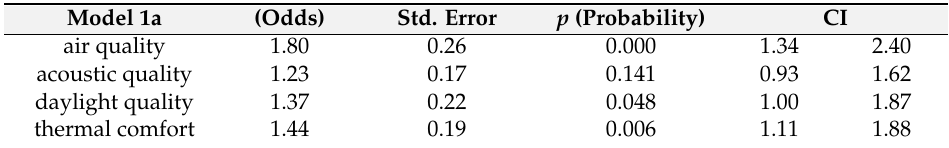
Table 7. Model 1a, ordinary logistic model describing the relationship between general satisfaction and perceived IEQ, N = 406; pseudo R-squared =